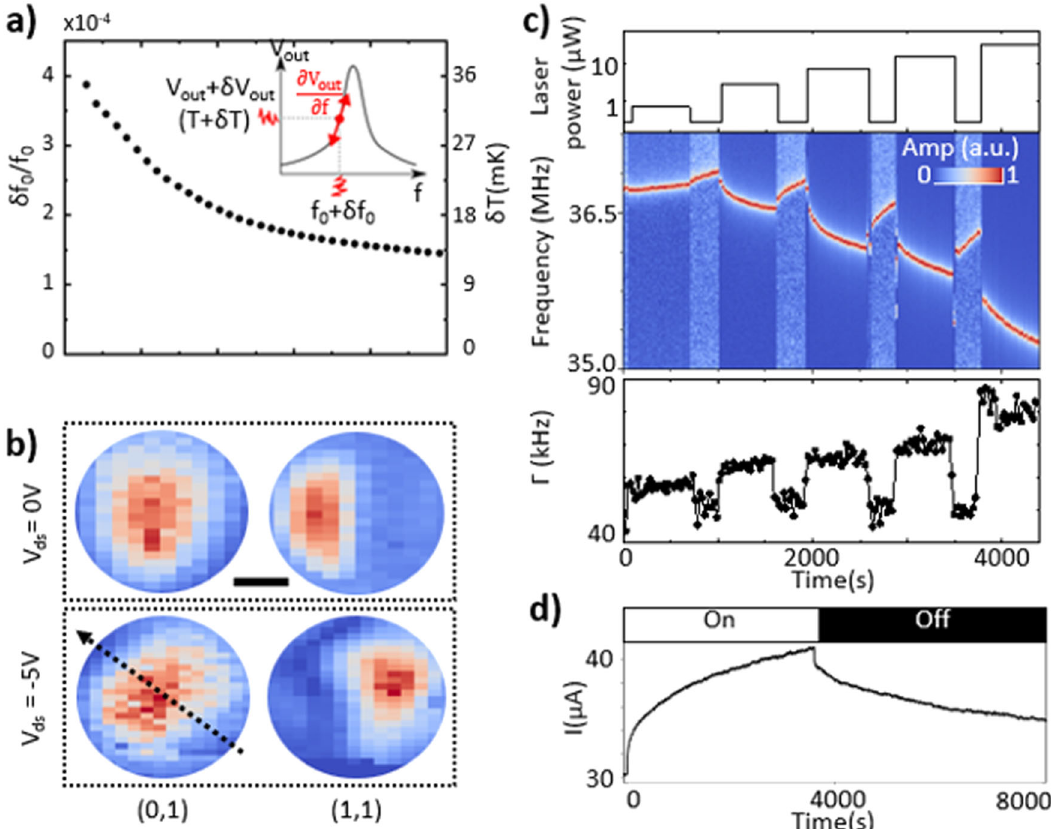
Fig. 4 Long living photothermal softening of the 2D membrane. a The Allan deviation of the mechanical resonance in function of the integration time, measured over a period of hundreds of seconds 47 . In insert, a schematic to explain the measurement of frequency and temperature noise at mid amplitude along the mechanical response. b Spatial cartography of the two fi rst mechanical modes of the drum at two different values of V ds . The higher mode (1.1) is observed at high V ds in ( a ). The fi eld direction is indicated with the black dot arrow. Scale bar: 1 µm. c Measurement of the mechanical signal response and the damping rate Γ in function of time for different switching of the incoming laser power, from 300nW to 30 µW. For minimum power, at 300 nW, the response signal has been arti fi cially enhanced for clarity. After some time without any light, the initial frequency is recovered. d Slow current variation over long time, I ds (t), when the laser is switch on and the laser is switch